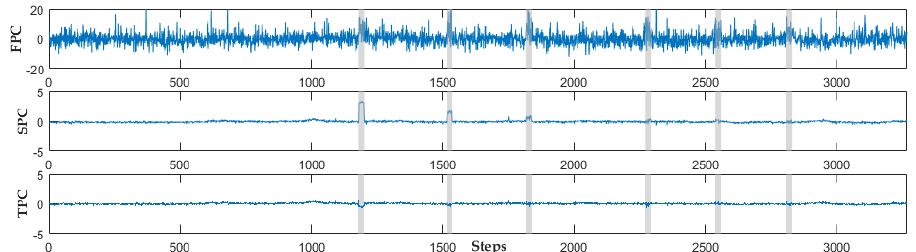
Figure 10. The first to third principal components of the original spectrum of phenol samples. FPC represents the first principal component of the UV-Vis spectrum; SPC represents the second principal component of the UV-Vis spectrum; TPC represents the third principal component of the UV-Vis spectrum.